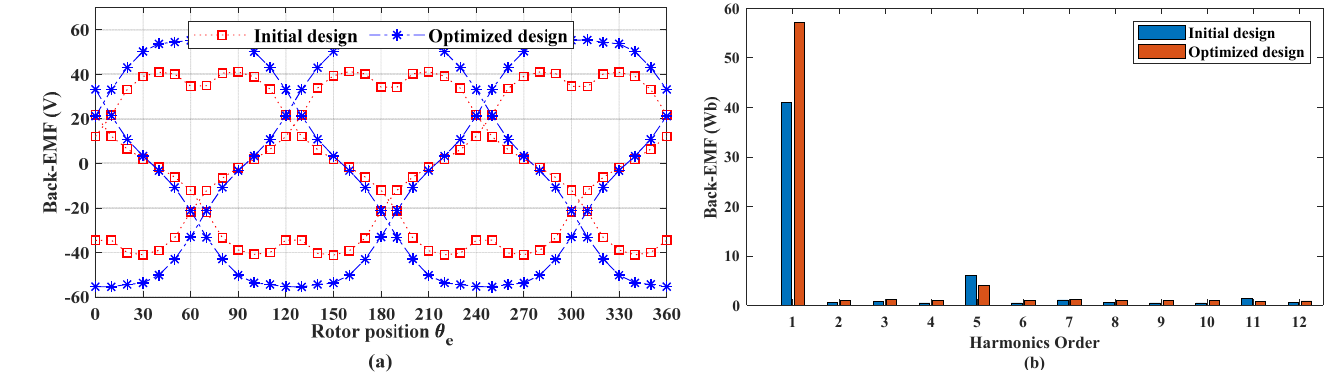
Figure 13. Cogging torque analysis of initial and optimized design. 5.2. Load Analysis Under loaded and rated operating conditions of 𝐽 (cid:3028) = 𝐽 (cid:3032) = 15 A/mm (cid:2870) and speed of 1500 rpm, instantaneous torque profile of 12S/13P is shown in Figure 14, which offers a 41.99% improvement in torque and 87.76% in Torque ripple ratio (𝑇 (cid:3045)(cid:3045) ) . Furthermore, av- erage torque profiles with torque ripples under different electric loading are illustrated in Figure 15, demonstrating the over-load capability of the proposed OR-FEFSM before and after optimization. It can be seen that under all-electric loading conditions, average torque increases, whereas the torque ripple ratio decreases. From the analysis, the torque and ripples ratios are improved by 41.99% and 87.76%, respectively, at the rated conditions. The formula for calculating torque ripple ratio is discussed in (5). 𝑇 (cid:3045)(cid:3045) = 𝑇 (cid:3040)(cid:3028)(cid:3051) − 𝑇 (cid:3040)(cid:3036)(cid:3041) 𝑇 (cid:3028)(cid:3049)(cid:3034)